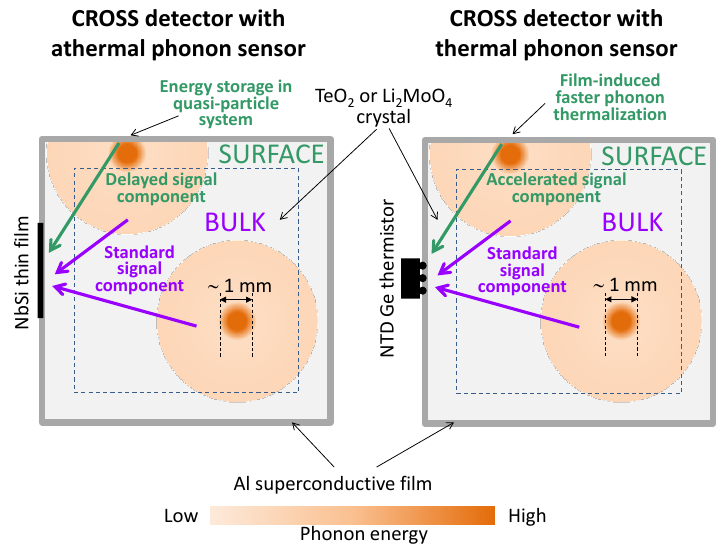
Figure 1 . Qualitative scheme of the mechanism of surface-event identi(cid:12)cation in CROSS. The time response of the phonon sensors depends on the distance of the particle energy deposit from the superconductive Al (cid:12)lm. If the (cid:24) 1 mm-size phonon hot spot reaches the (cid:12)lm, an athermal- phonon sensor will provide a delayed signal with respect to a bulk event (left panel) due to energy trapping in the form of quasi-particles. Conversely, a thermal-phonon sensor will provide a faster signal with respect to a bulk event (right panel) as the (cid:12)lm accelerates the phonon thermalization process. Signals from athermal-phonon sensors are anyway globally faster than those from thermal- phonon